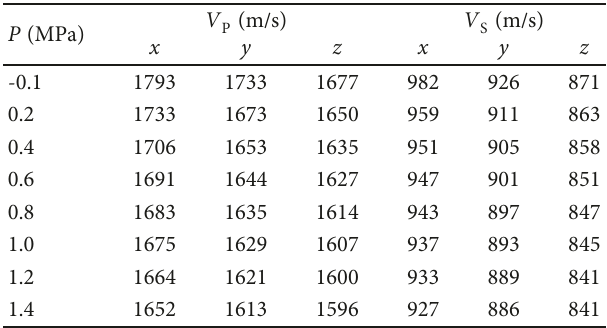
Table 3: Test results of P- and S-wave ultrasonic velocities of the coal samples under di ff erent gas